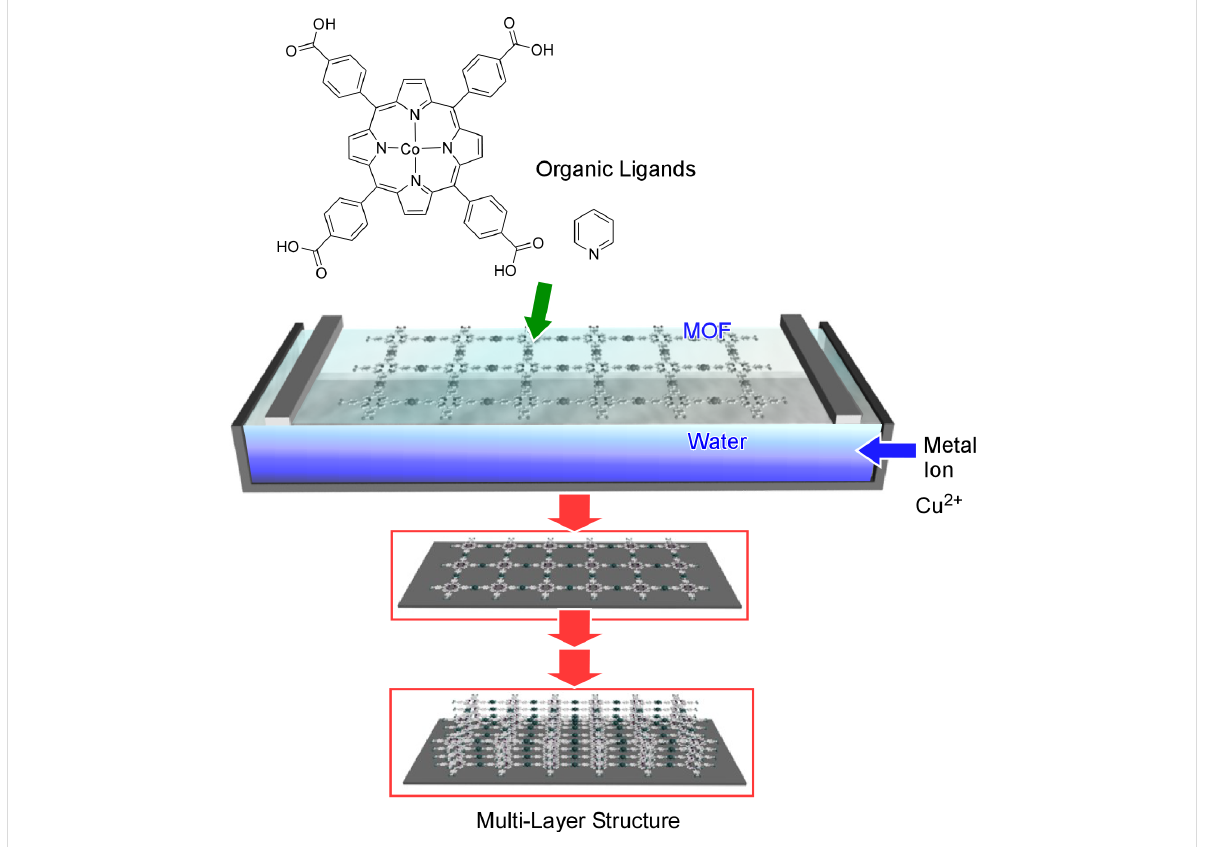
Figure 10: Fabrication of a multilayer of oriented porphyrin-based MOF films by repeatingly transferring and washing interfacially grown MOF layers.